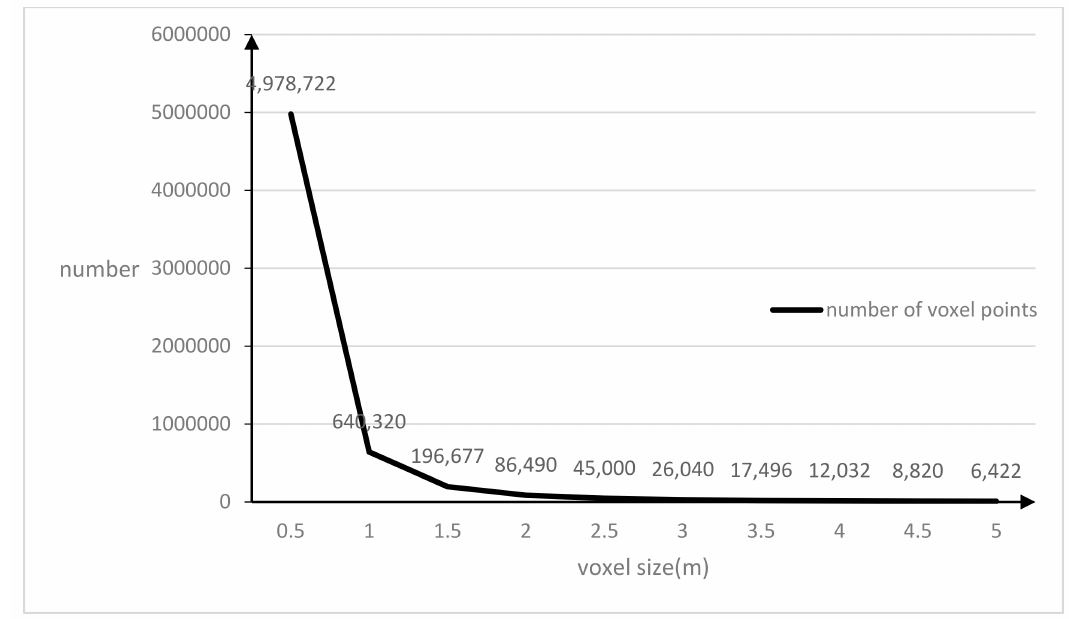
Figure 9. The relationship between the number of voxel points and the voxel size.